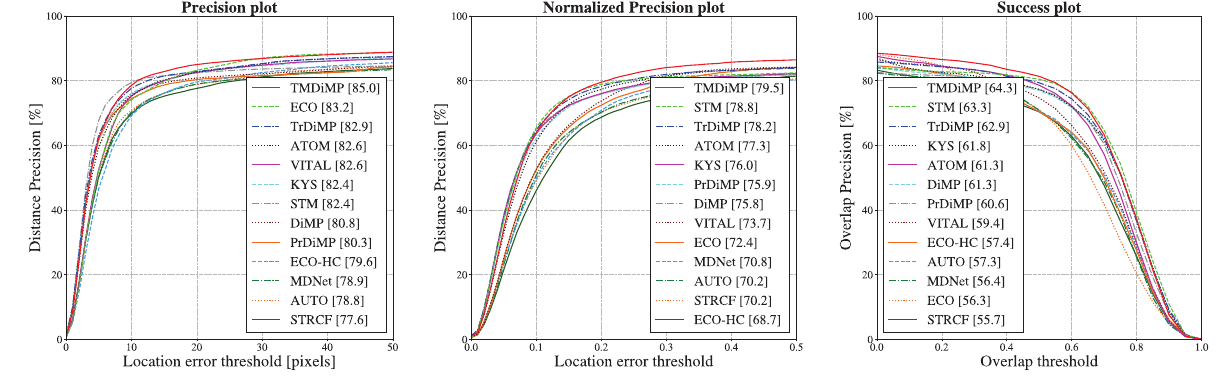
Figure 11. Precision, normalized precision, and success plots of OPE on